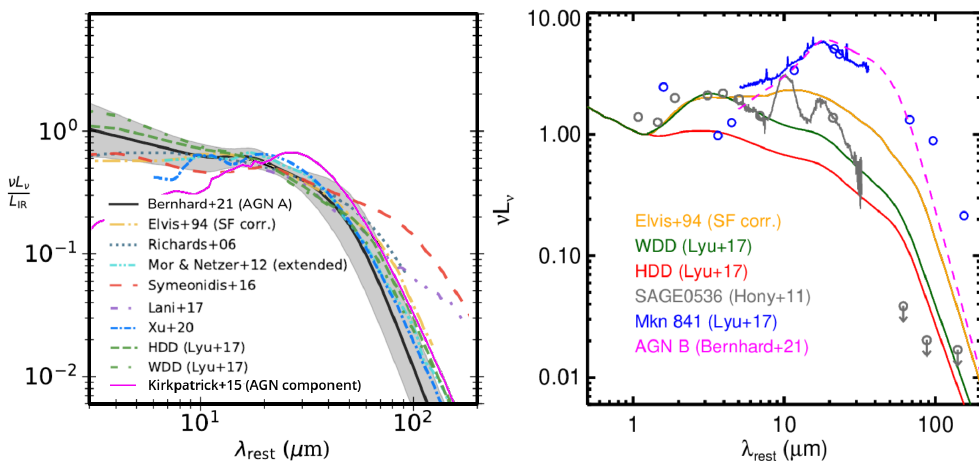
Figure 8. ( Left panel): comparison of various AGN templates for relatively luminous AGNs or quasars, corrected for host galaxy contribution in the far-IR. These templates are normalized by their IR luminosity. A general agreement is revealed for most papers (modified based on Figure 14 in Bernhard et al. [82]). ( Right panel): similar to the left, we only show the normal Elvis-like AGN template [52]; the WDD and HDD AGN templates [86], normalized in the optical band; the AGN-B template (for less luminous AGNs [82]); plus the observed SEDs of AGE1CJ053634.78-722658.5, an extreme AGN at z ∼ 0.14 reported by Hony et al. [94], and of Mkn 841, a well-studied PG quasar. The spectrum for it includes a substantial contribution from the host galaxy for wavelengths short of 10 µ m; the AGN-only SED is shown by the open